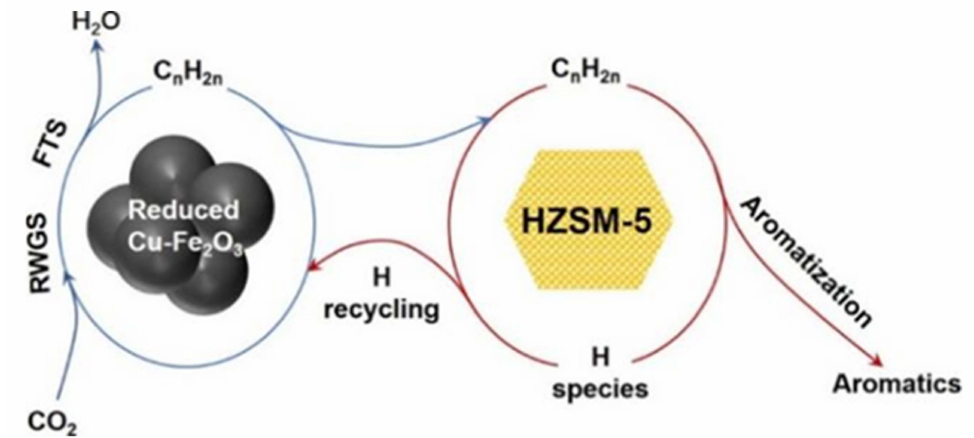
Figure 23. Schematic illustration of the “H recycling” mechanism for CO 2 hydrogenation to aromatics between oxide and zeolite. Reprinted with permission from Song et al. [115]. Copyright (2020) American Chemical